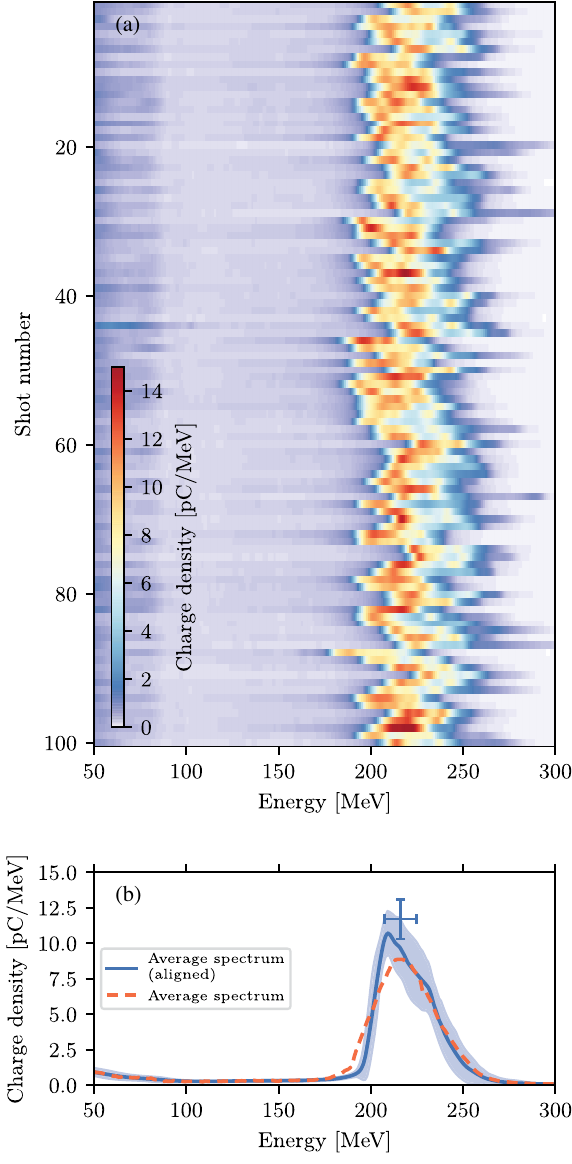
FIG. 2. Optimal performance of the shock-front injector with a 75-TW laser (a quantitative analysis is given in the text below). according to their central energy. The error bar marks the fluctuations in peak spectral charge density and